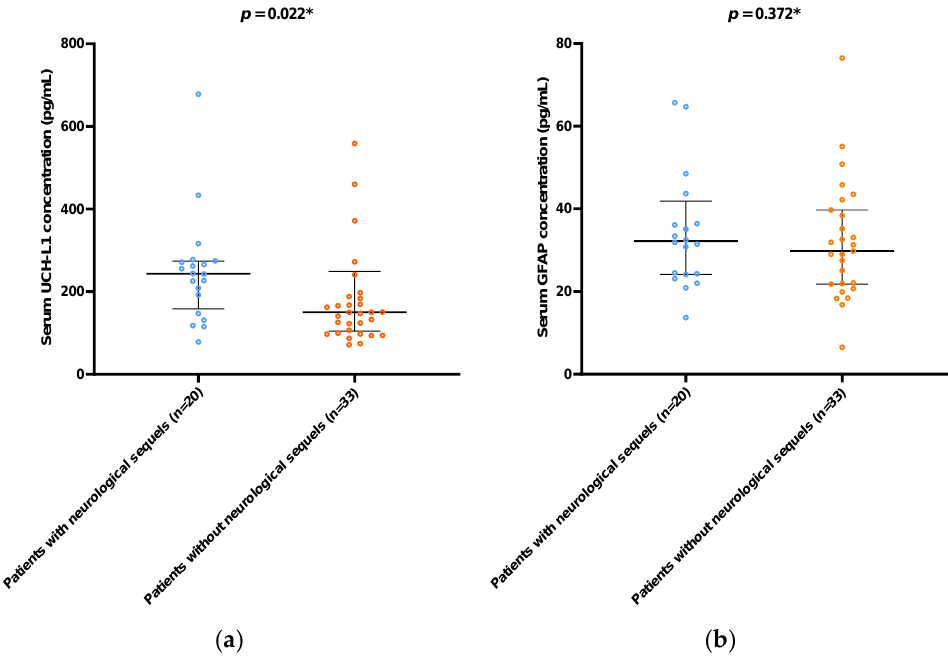
Figure 2. Comparison of UCH-L1 and GFAP serum concentrations on ICU admission between patients with and without neurological sequels: ( a ) UCH-L1; ( b ) GFAP. Abbreviations: UCH-L1: Ubiquitin carboxy-terminal hydrolase L1; GFAP: glial fibrillar acidic protein; ICU: intensive care unit. Data are presented in the median and interquartile range. * Mann – Whitney U test.